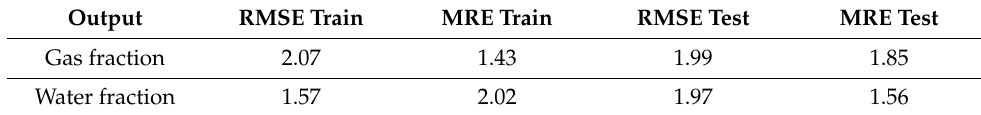
Table 3. Calculated the network’s